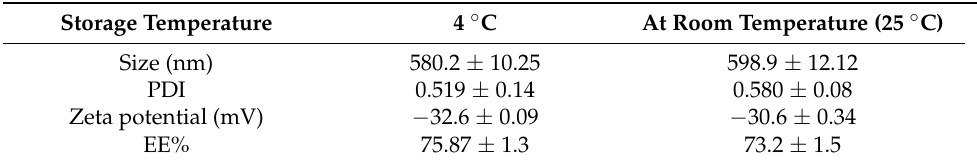
Table 3. Vesicle size, zeta potential, polydispersity index (PDI), and encapsulation efficiency (EE %) GSH-loaded NLCs stored at 4 ◦ C and at room temperature for one month.